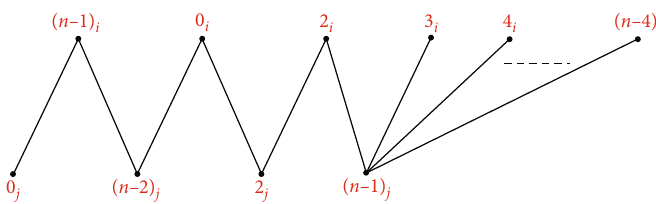
1, 0, 0, 0, 0, n − 6 ÞÞ i , j 6 ð